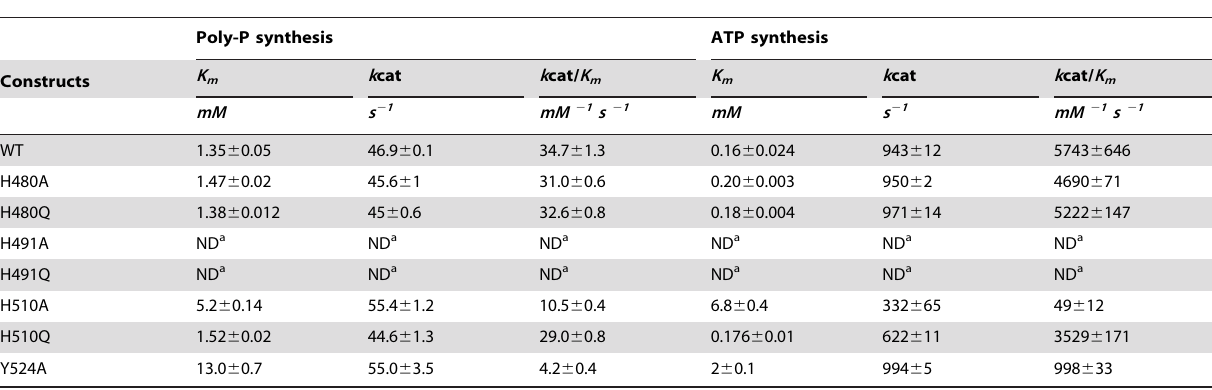
Table 1. Kinetics for poly-P and ATP synthesizing activities by PPK1 mutants.